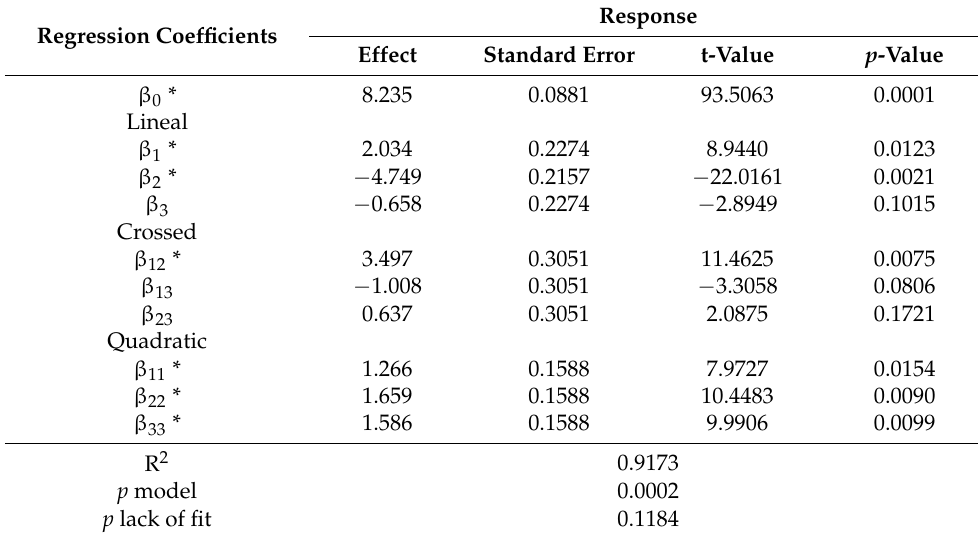
Table 5. Estimated regression effects of the fitted second-order polynomial equation and ANOVA of the fitted model.